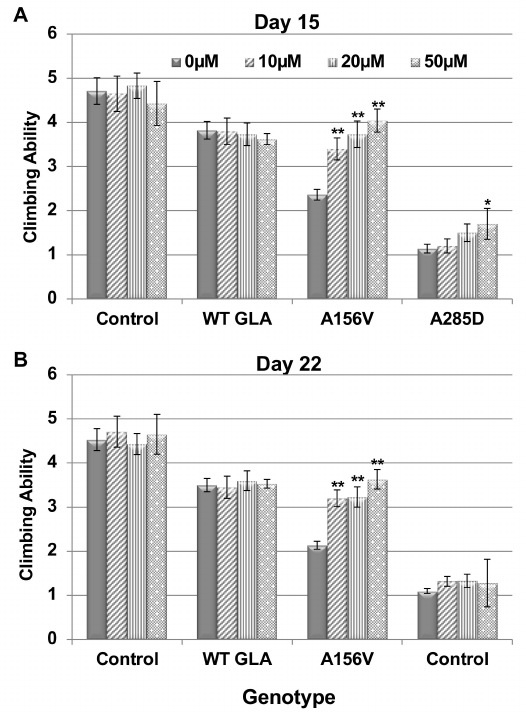
Figure 4. Climbing ability of GLA transgenic flies. ( A , B ) Transgenic flies treated with di ff erent concentrations of migalastat were analyzed for climbing ability at days 15 ( A ) or 22 ( B ) post-eclosion. The results are the mean ± SEM of three independent experiments. The expression of the α -Gal A mutant variants was under the dopa decarboxylase GAL4 driver (DdcGAL4). Statistical analysis included three-way ANOVA (to show the significance of the reaction of the di ff erent genotypes to di ff erent migalastat concentrations and test if there is a di ff erence between the di ff erent days evaluated), followed by one-way ANOVA with post-hoc Dunnett test. Significance: * p < 0.05; ** p <